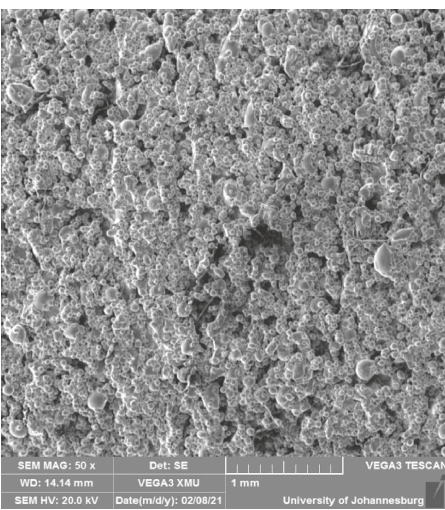
Figure 3: The SEM image showing the as-built Ti-6Al-4V with unmelted powders adhered to the